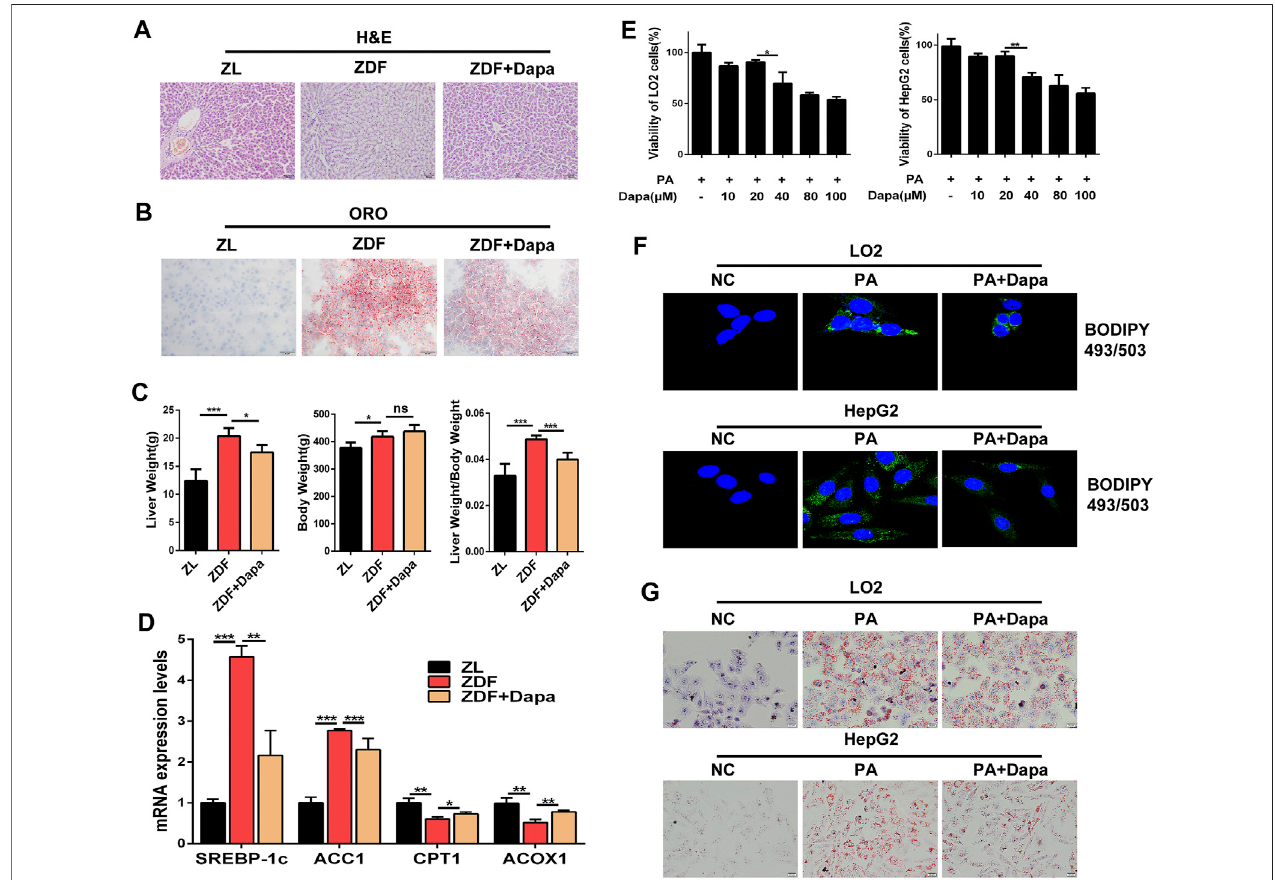
FIGURE 2 | Dapagli fl ozin alleviates hepatic lipid accumulation in ZDF rats and PA-stimulated LO2 and HepG2 cells. (A, B) Liver sections were stained with H&E (Scale bars: 50 μ m)and Oil Red O (Scale bars: 20 μ m). (C) Liver/body weight ratio was calculated by liver weight (g)/body weight (g). (D) The mRNA expression levels of hepatic lipogenic genesACC1, SREBP-1c, andfatty acidoxidation genesCPT1 andACOX1 wereexaminedbyreal-time q-PCR (E) CCK-8assaysindicate theeffectof dapagli fl ozin (10, 20, 40, 80, and 100 μ mol/L) on the viability of HepG2 cells and LO2 cells. (F) HepG2 cells and LO2 cells were stained with 1 μ g/ml BODIPY 493/ 503and fl uorescenceimageswerecapturedbyaconfocalmicroscope. (G) LO2andHepG2cellswerestainedwithOilRedO.Scalebars:20 μ m.Dataareexpressedas the means ± SEM from three independent experiments. * p < 0.05, ** p < 0.01, and *** p <